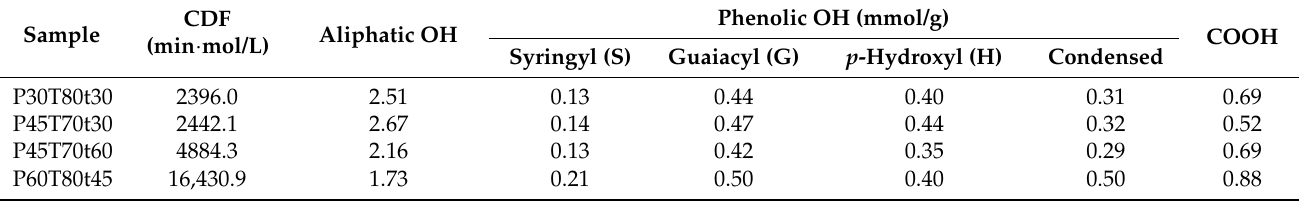
Table 3. Quantification of the functional groups in lignin by 31 P NMR